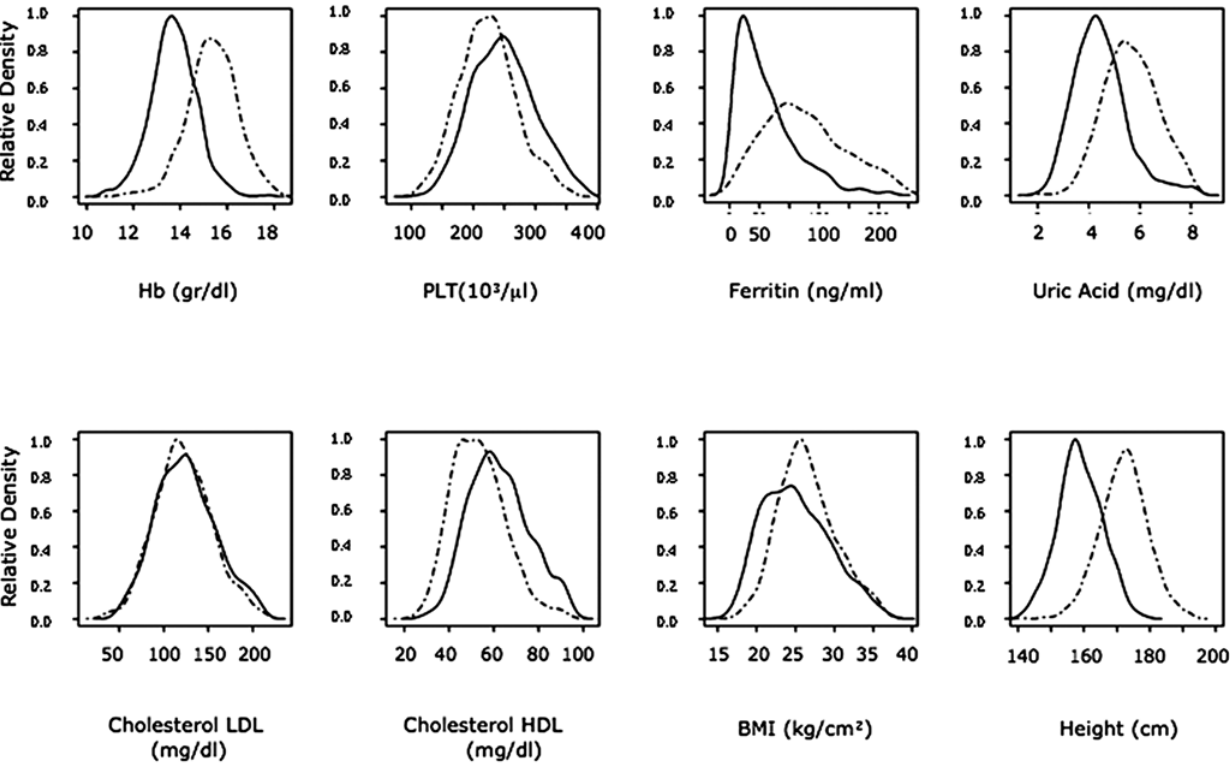
Figure 5. Distribution of eight representative traits in male and female participants. Relative densities were plotted for females (continuous line ) and males (dotted lines) for two blood cell measures (Hb and PLT), and for four serum (Ferritin, Uric Acid, Cholesterol LDL, Cholesterol HDL) and two anthropometric measures (BMI and Height). Abbreviations are as in table 1 and 2.